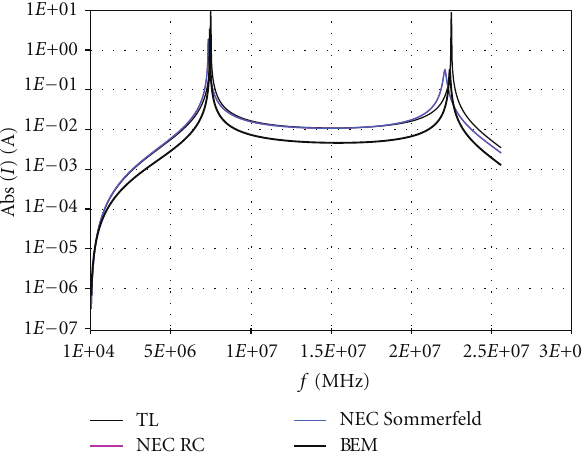
Figure 5: Current induced at the center of the line above a PEC ground versus frequency.